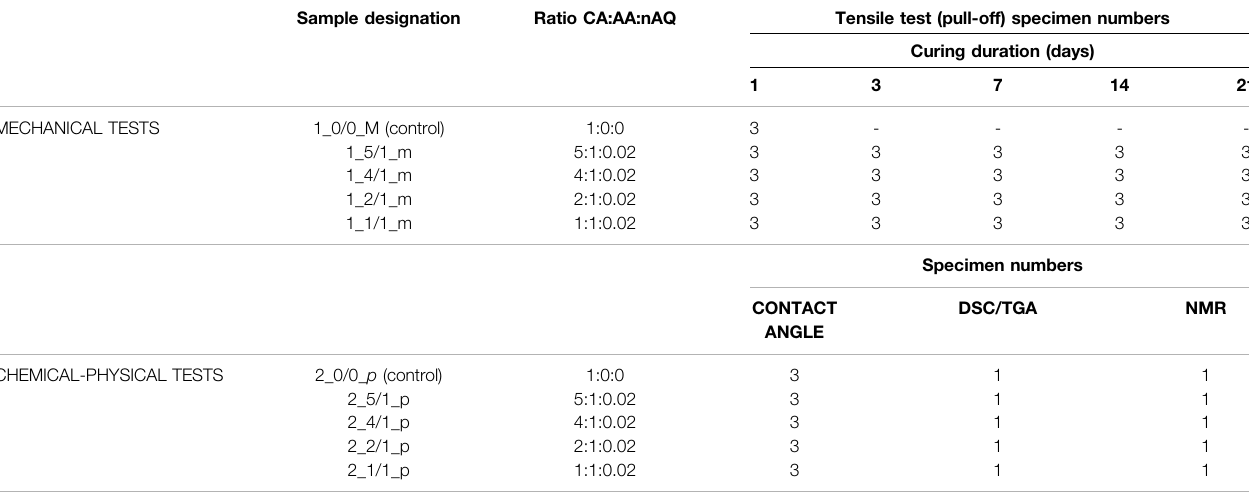
TABLE 6 | Details of the experimental